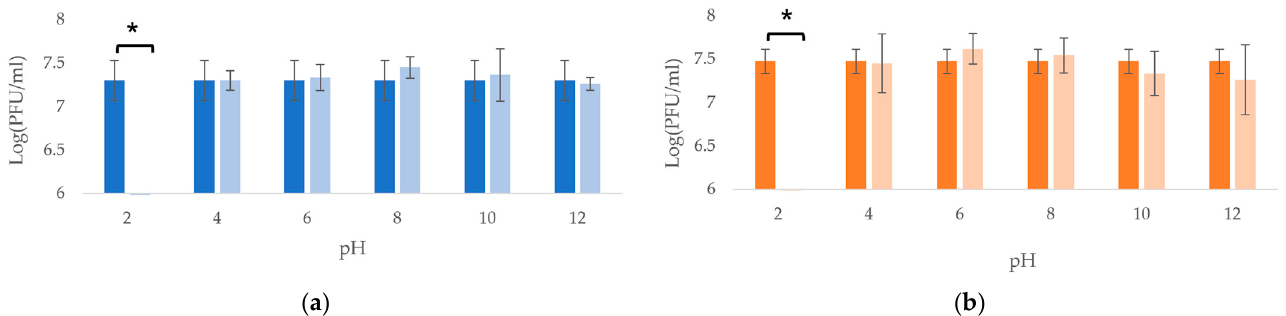
Figure 2. Comparative genomics of bacteriophages vB_KpnP_K3-ULINTkp1 and vB_KpnP_K3- ULINTkp2 with bacteriophages phiKpS2, vB_KpnP_SU503, and vB_KpnP_NER40.